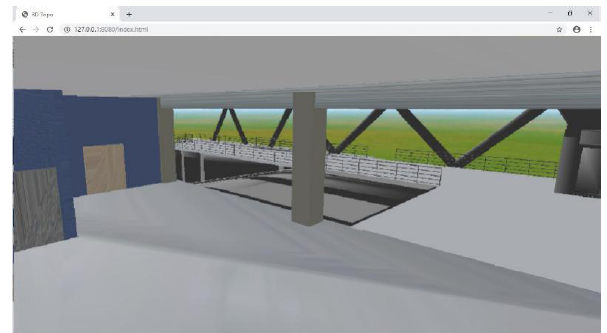
Figure 3. 3D visualisation of the building layout on the website.